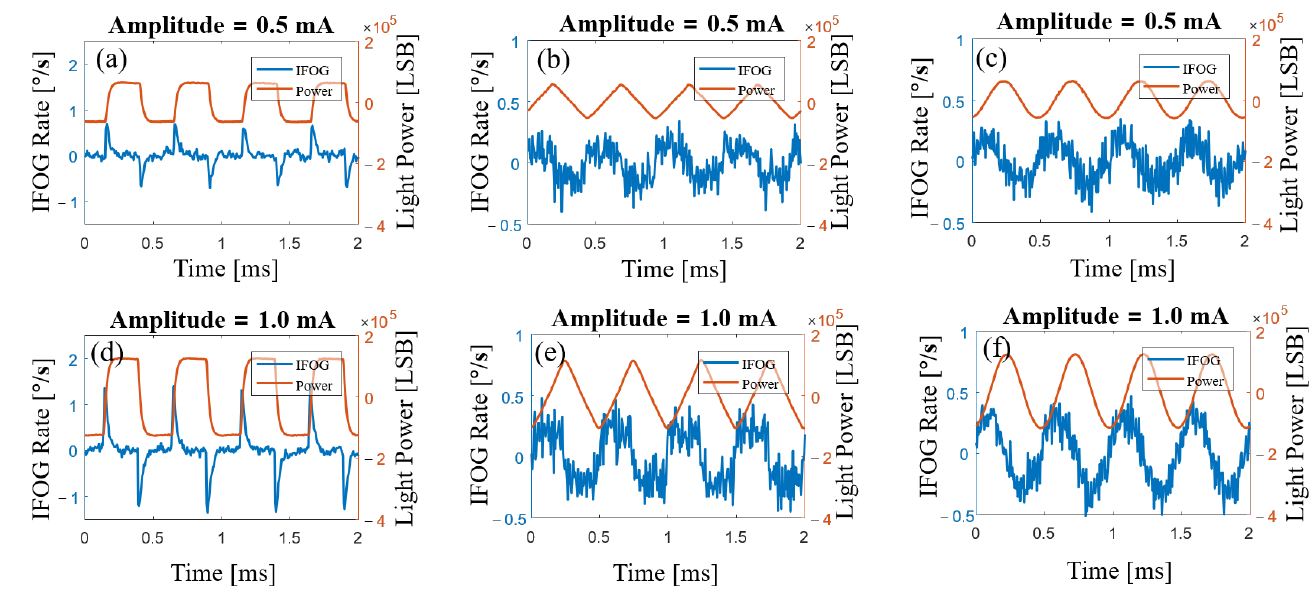
Figure 7. SLD power signal and original output signal of the gyroscope. The driving currents of the SLD in the experiments had the same bias of 100 mA. ( a , d ) Square-wave driving currents of the SLD with 0.5 mA and 1.0 mA amplitudes. ( b , e ) Triangle-wave driving currents of the SLD with 0.5 mA and 1.0 mA amplitudes. ( c , f ) Sine-wave driving currents of the SLD with 0.5 mA and 1.0 mA amplitudes.